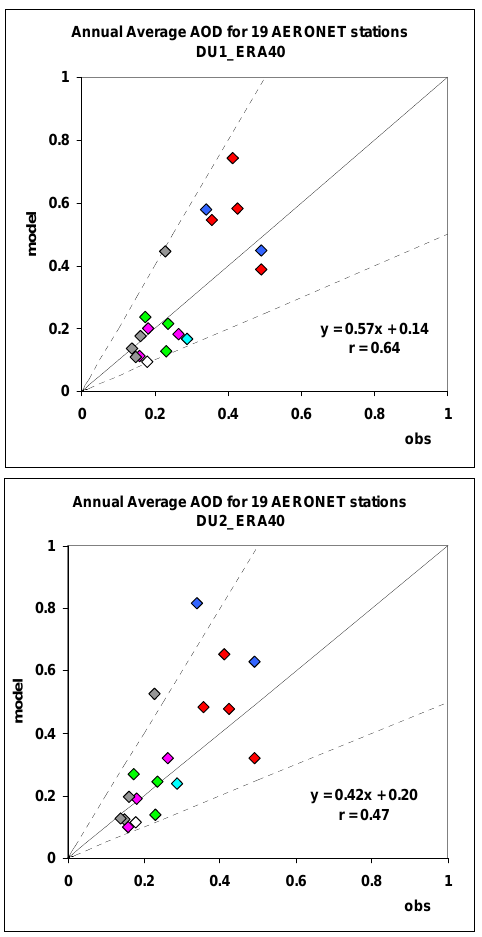
Fig. 13. Scatter plots of the modelled versus AERONET mea- sured annual AOD550nm for the DU1 ERA40 (upper plot) and for the DU2 ERA40 (lower plot) simulations. The colour of the dots corresponds to the location of the stations: Africa = red, Indian Ocean = white, Europe = grey, Middle East = green, S- America = purple, Arabian Peninsula = blue, Asia = cyan. The dot- ted lines denote the 1 : 2 to 2 : 1